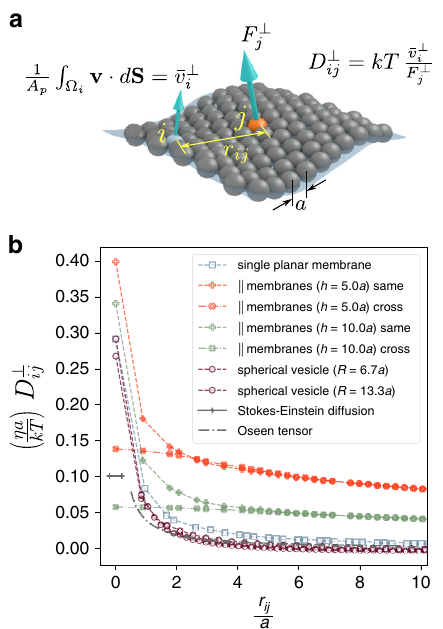
Fig. 2 Numerical calculation of the out-of-plane component of the diffusion tensor, D ? ij . a De fi nition of the D ? ij based on F ? j , the force existing between the fl uid domain and particle j , and the corresponding effective out-of-plane velocity, (cid:1) v ? i , attributed to particle i . The effective velocity results from averaging the velocity fi eld of the fl uid, in the direction normal to the membrane, in the vicinity of the membrane particles. b Compilation of numerical values of the D ? ij as a function of in-plane inter-particle distance, r ij . Results are, respectively, given for a single planar membrane, two sets of parallel membranes with the given inter-plane separations, and two spherical vesicles with the given radii. In the case of parallel membranes, the in-plane distance is measured solely based on planar coordinates, and for spherical vesicles, it is de fi ned along the geodesics. For these calculations, the parameter α is chosen equal to 0.1 a . Values given by the Stokes – Einstein relation, as well as the Oseen tensor are shown for